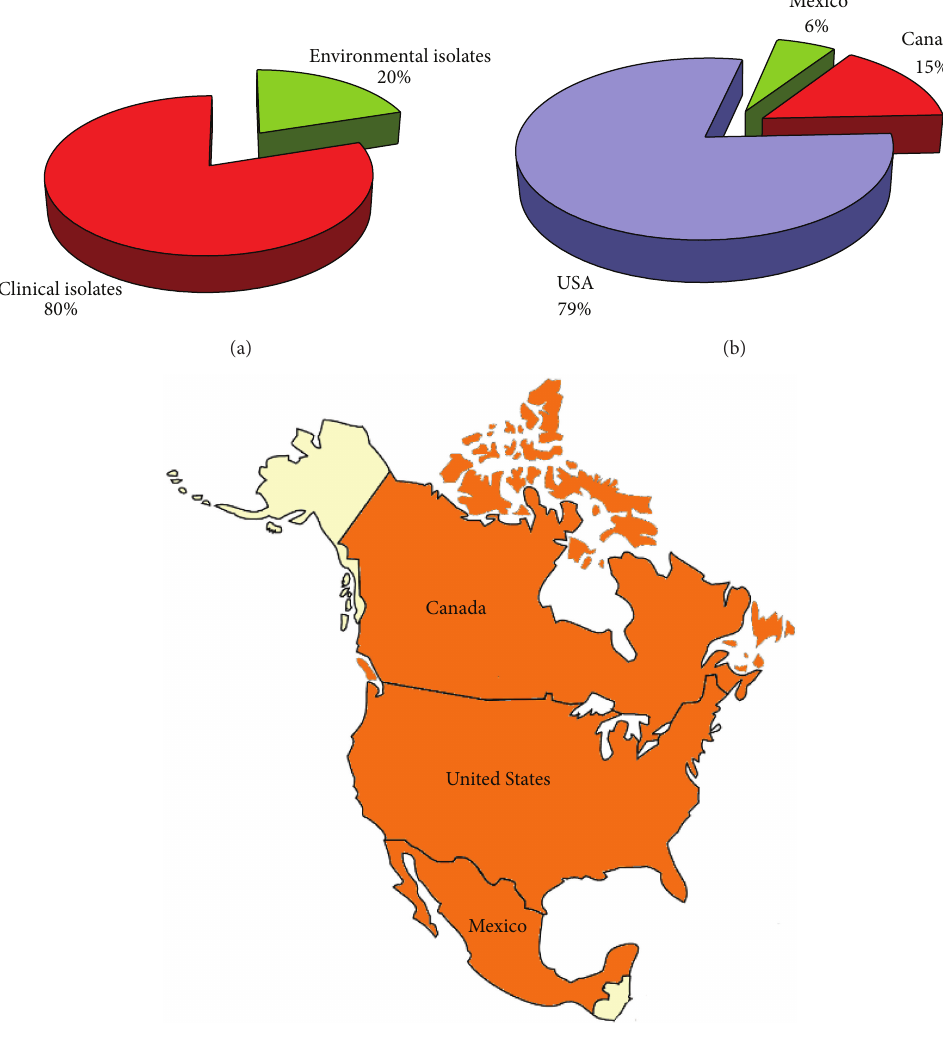
F 11: Percentage of Cryptococcus neoformans and Cryptococcus gattii isolates from clinical ( sources (a). Distribution of Cryptococcus neoformans and Cryptococcus gattii isolates in the different countries of North America (b). Map of the geographical distribution of the Cryptococcus neoformans and Cryptococcus gattii isolates in North America (c). Clinical isolates were reported from red-colored countries, whereas both clinical and environmental isolates were reported from orange-colored